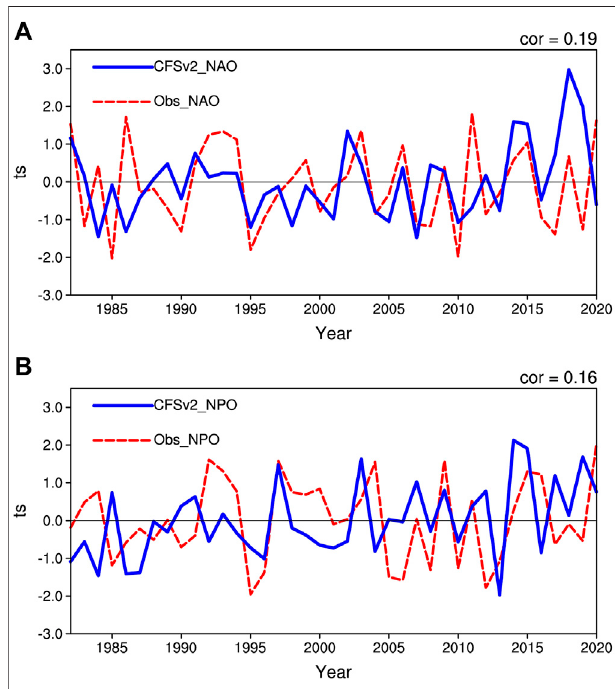
FIGURE 14 | Time series of the (A) November NAO index in the observation and the one-month-lead forecast of the CFSv2 ensemble mean and (B) November NPO index in the observation and the one-month-lead forecast of the CFSv2 ensemble mean.